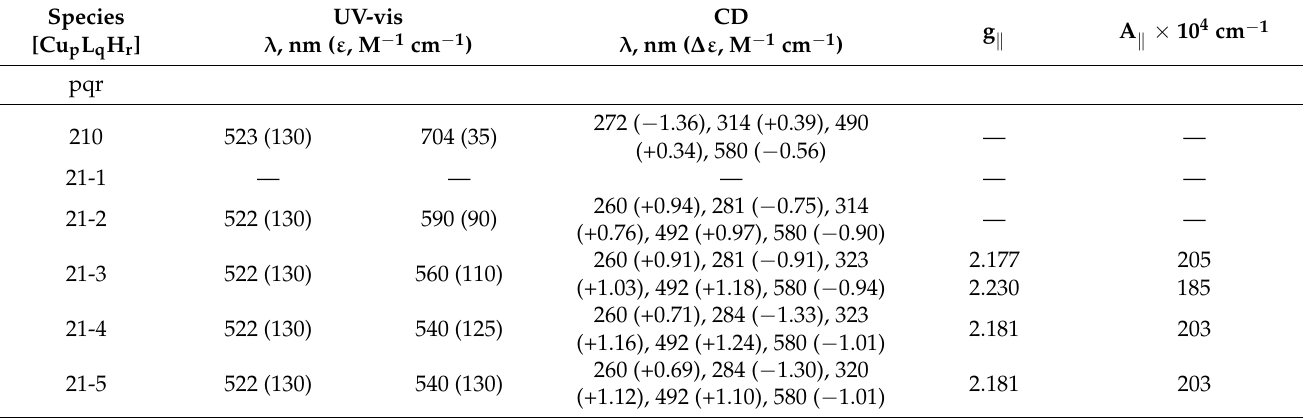
Table 2. Spectroscopic parameters obtained from the titration of the Cu 2+ -Ctr1 (1-14) .